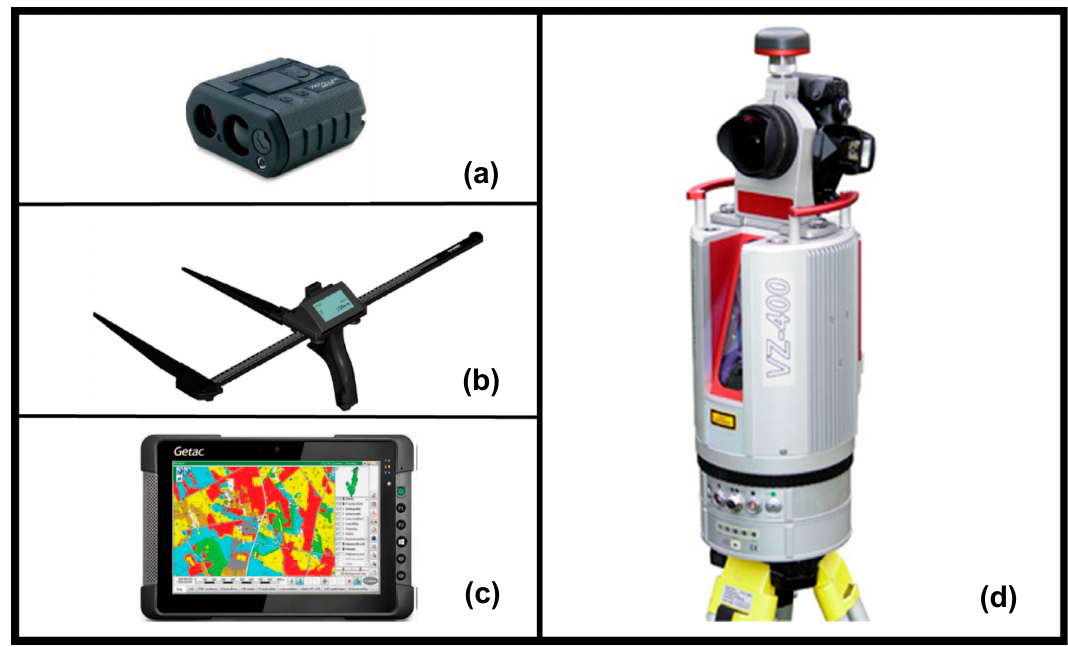
Figure 2. Electronic devices for the measurement of biometric variables: ( a ) Trupulse 360R, ( b ) BT MEM electronic caliper, ( c ) Getac T800 portable computer with Field-Map ® software bundle, and ( d ) TLS RIEGL VZ400.